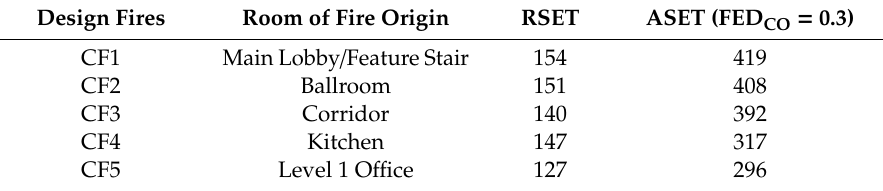
Table 6. RSET / ASET analysis for room of fire origin containing heritage surface